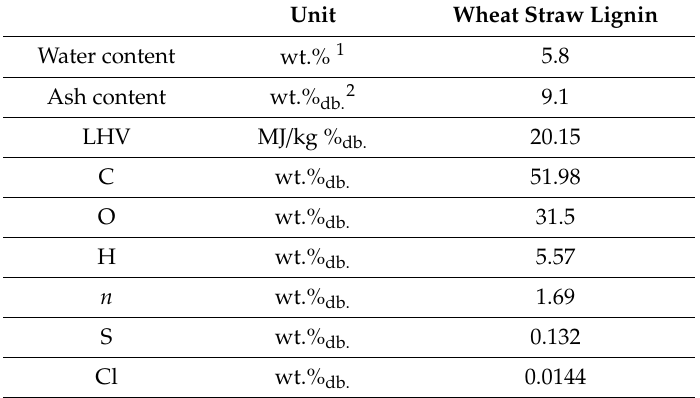
Table 1. Elemental analysis, lower heating value (LHV), water and ash content of wheat straw